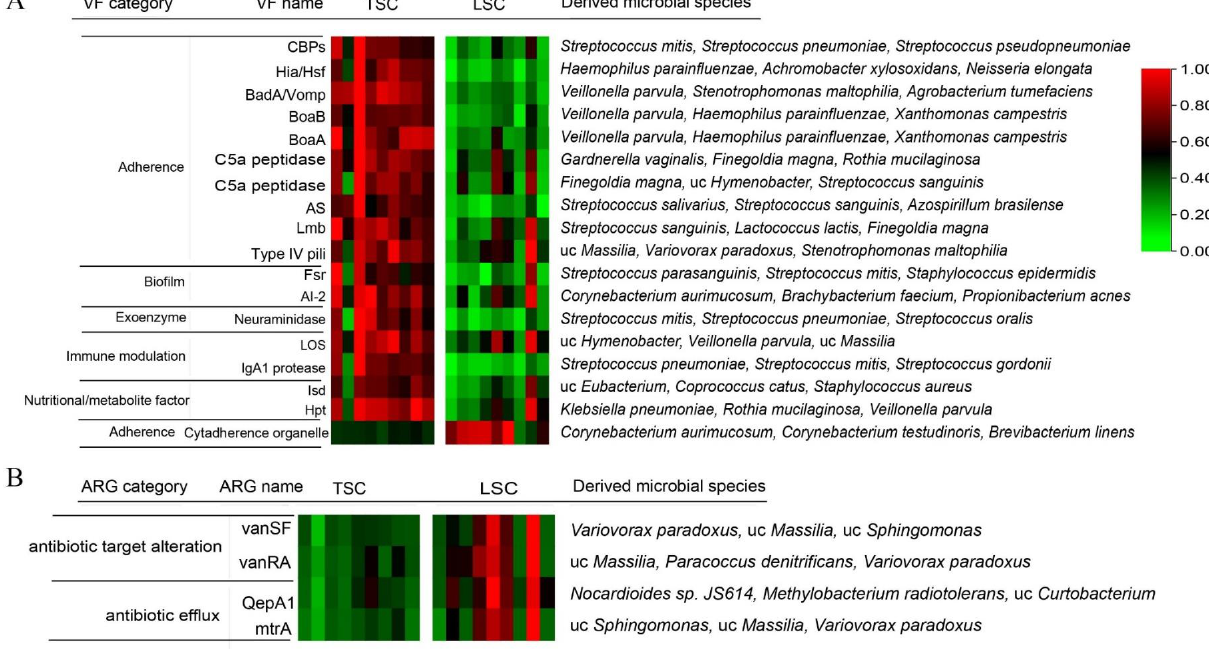
Figure 2. Relative abundances of virulent factors (VFs) and antibiotic resistance genes (ARGs) enriched in TSC and LSC. Only significantly enriched ( A ) VFs and ( B ) ARGs in TSC and LSC are shown (LDA > 2, p -value < 0.01 in LEfSe analysis, and abundance fold changes >1.5 or <0.67). Heatmaps show the relative abundances of VFs and ARGs, with the most abundant being defined as 1. The potential microbial sources of each VF or ARG were identified by searching all sequences against the NCBI-NT databases. The three most abundant microbial sources are listed in the table as the main sources of the VFs/ARGs.